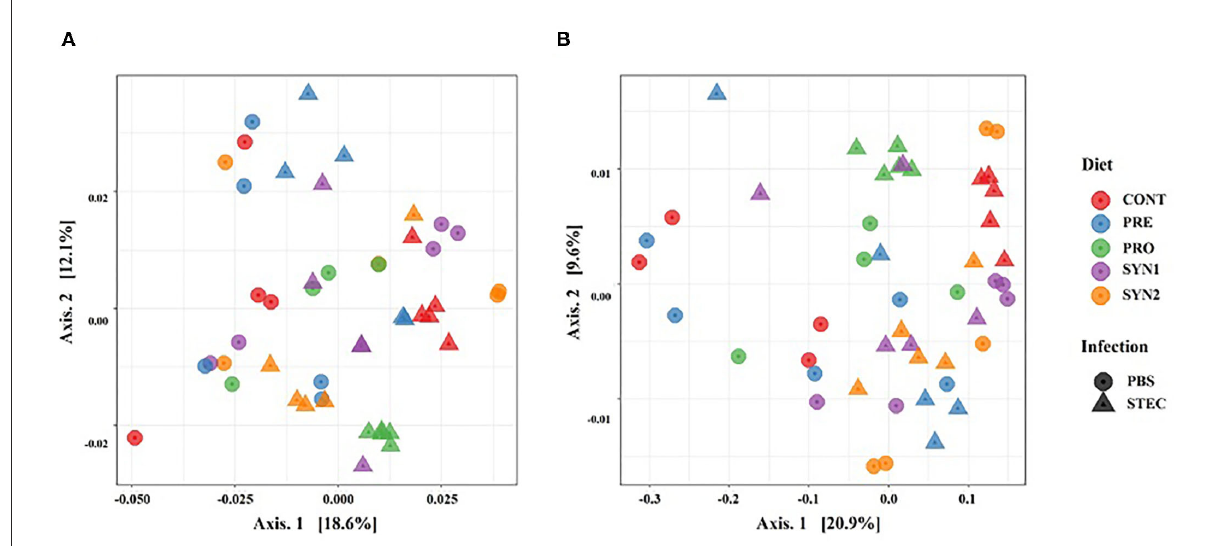
FIGURE2 Beta diversity analysis of the pig gut microbiota of the pig groups PRE, PRO, SYN1 and SYN2 with or without STEC challenge. Principal coordinates analysis (PCoA) plots based on the weighted (A) and unweighted (B) UniFrac distances of gut microbial communities. Each symbol represents the microbiota from individual pig sample and were color coded according to treatment group (CONT, PRE, PRO, SYN1 and SYN2) while shape represents the oral challenge with STEC (circle) and PBS (triangle) . The axes show the percent